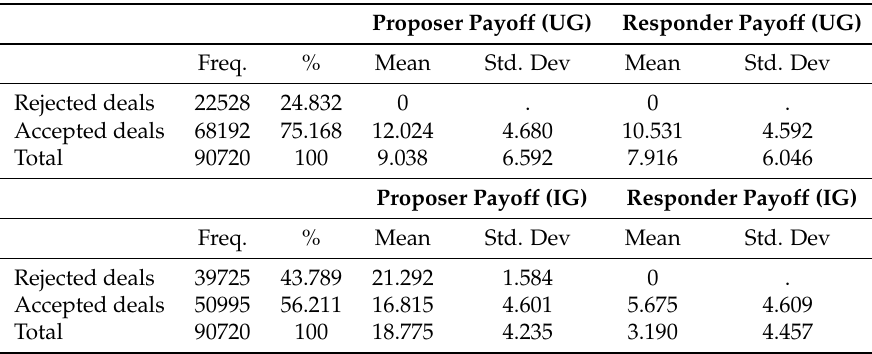
Table 6. Payoff analysis by acceptance rate (simulated